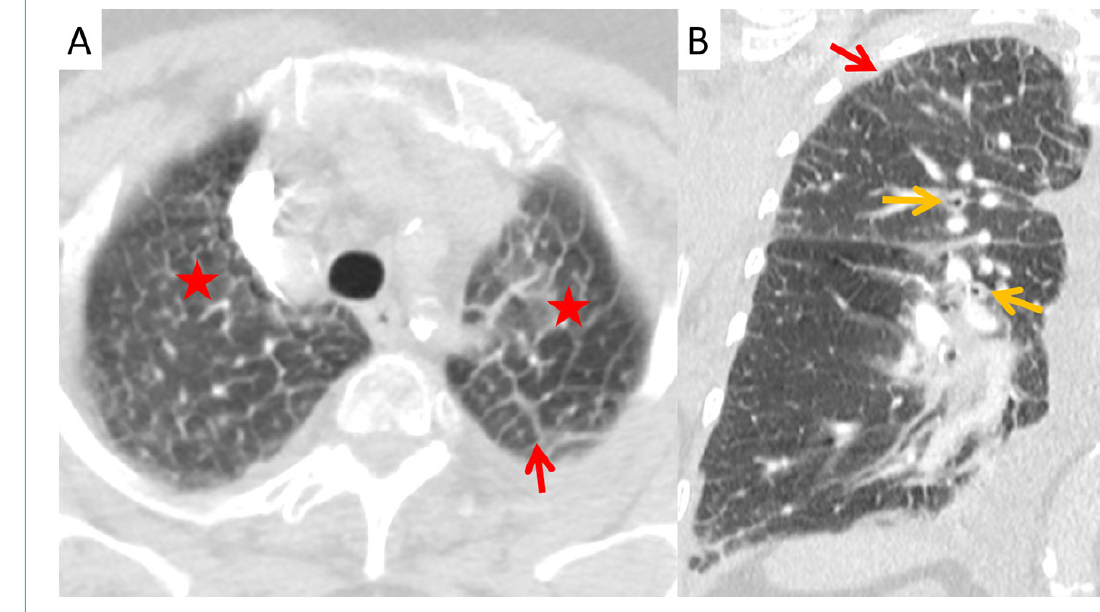
Figure 4: Apical Kerley B lines (red arrows) in (A) axial and (B) coronal planes with peribronchial cuffing (orange arrows) and ground glass opacities (asterisk) from transudation in a 63-year-old male patient with renal